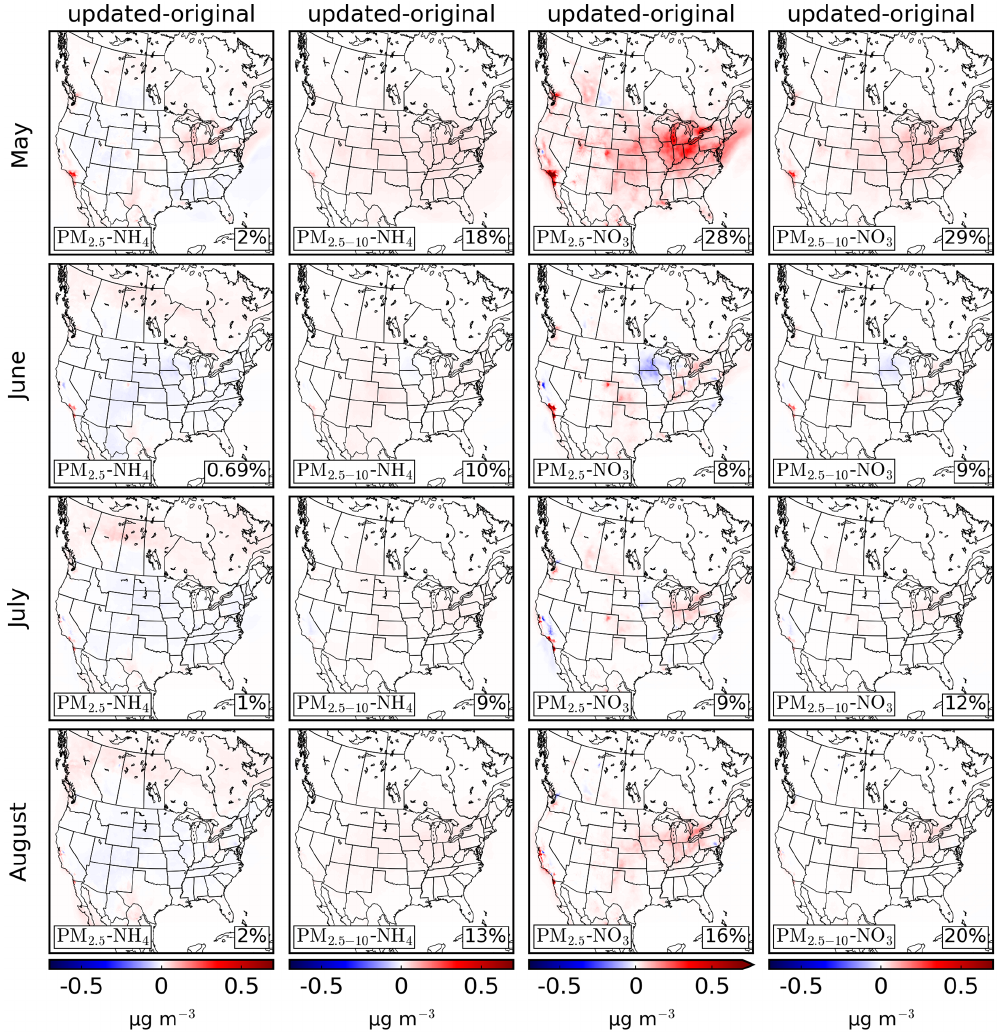
Figure 12. Monthly mean differences of GEM-MACH surface fields for fine- (PM 2 . 5 ) and coarse-fraction (PM 2 . 5 − 10 ) ammonium and nitrate for May to August 2016. Plots show mean differences between the run with the updated ammonia emissions and the original emissions. The total difference over the model domain as a percentage of the original field is shown in the lower right corner of each plot.